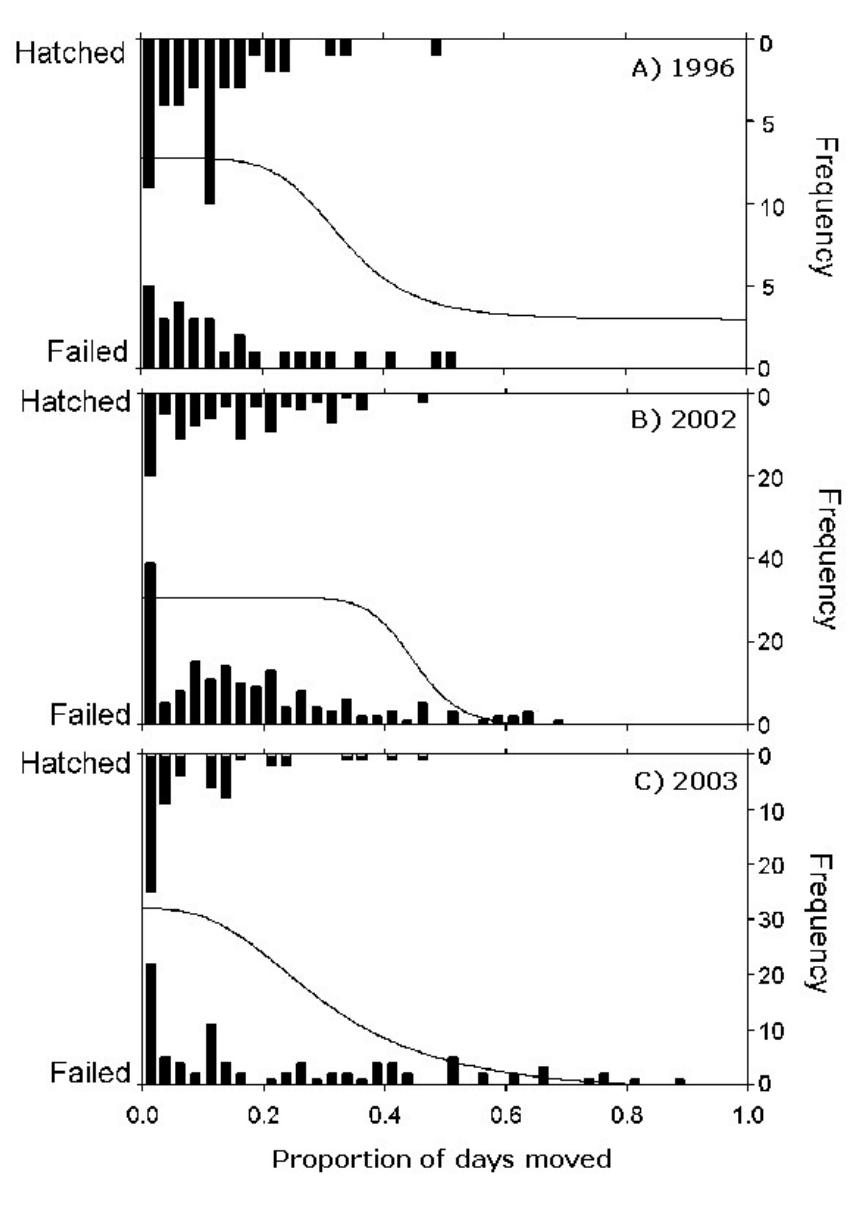
Fig. 3 . Logistic regression of hatching fate on proportion of days with movement for 75 nests in 1996, 274 nests in 2002, and 153 nests in 2003. Vertical bars indicate number of points falling in each proportion interval (width =